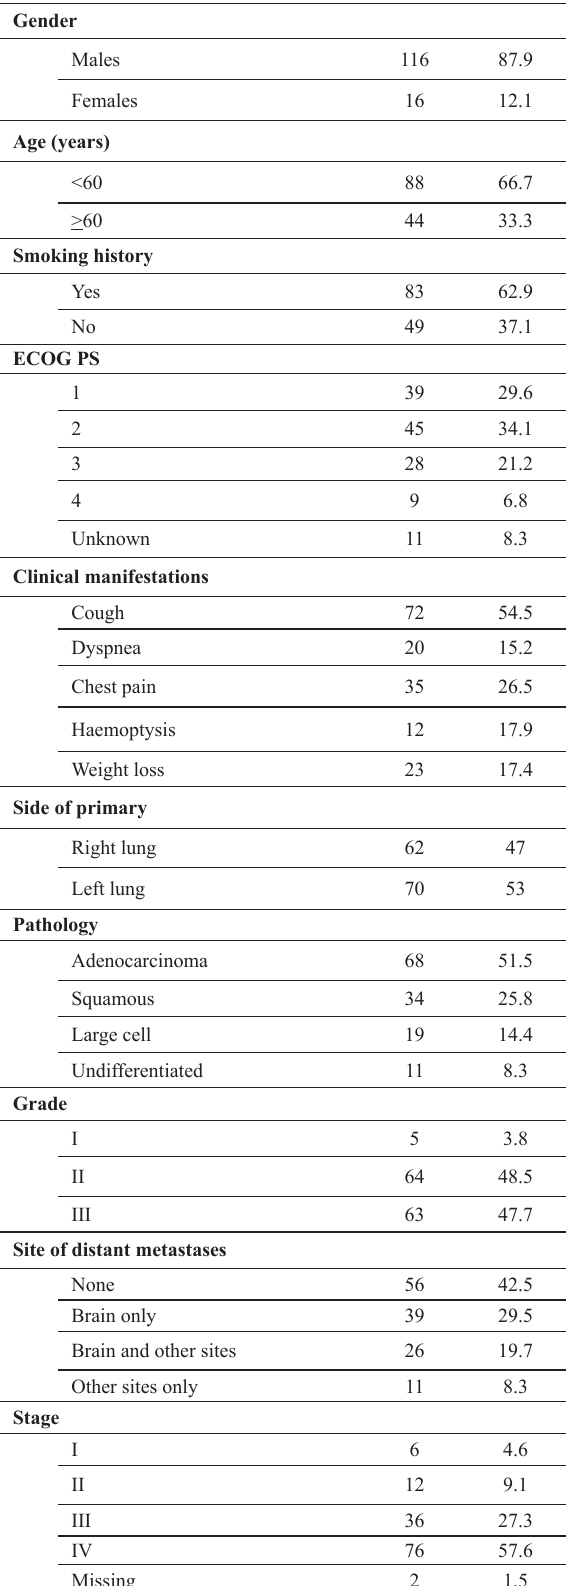
table 1: Patients' characteristics at presentation. table 2: Presentation and treatment of brain